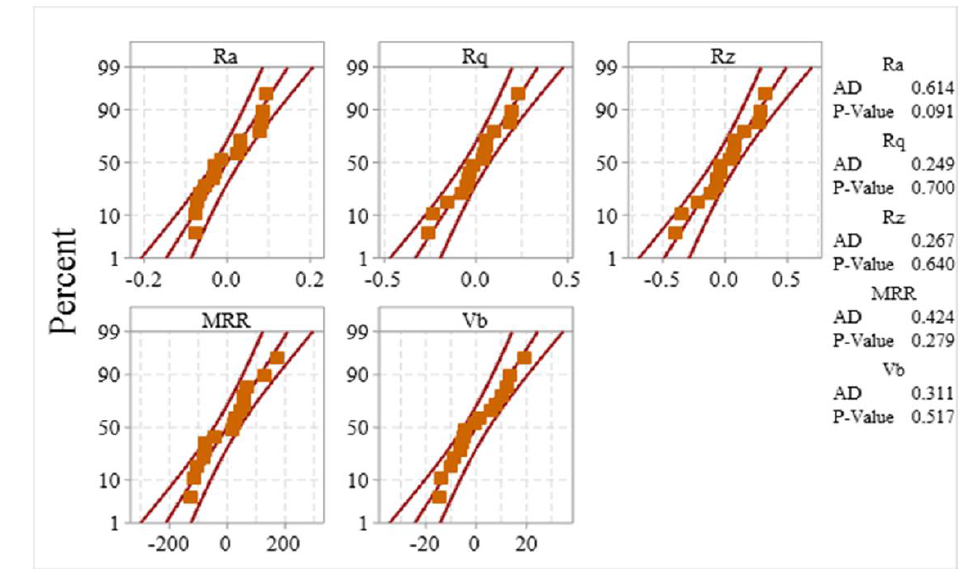
Figure 6. Normal probability plots of responses.